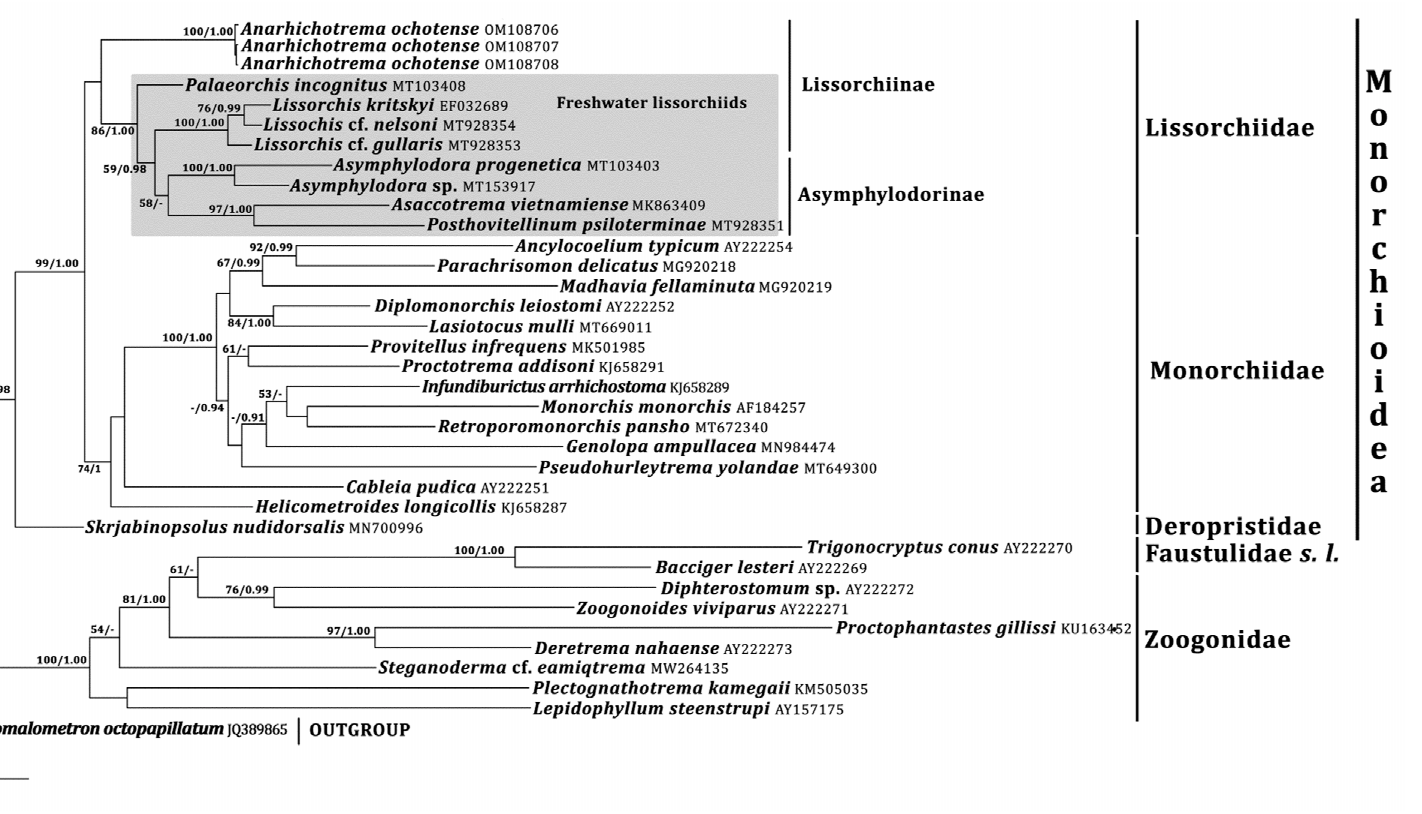
Figure 1. Phylogenetic relationships of Anarhichotrema ochotense based on dataset of 28S rRNA gene sequences. The bootstrap ( ≥ 50) and posterior probability ( ≥ 0.90) values are given near the nodes for ML and BI analyses, respectively.